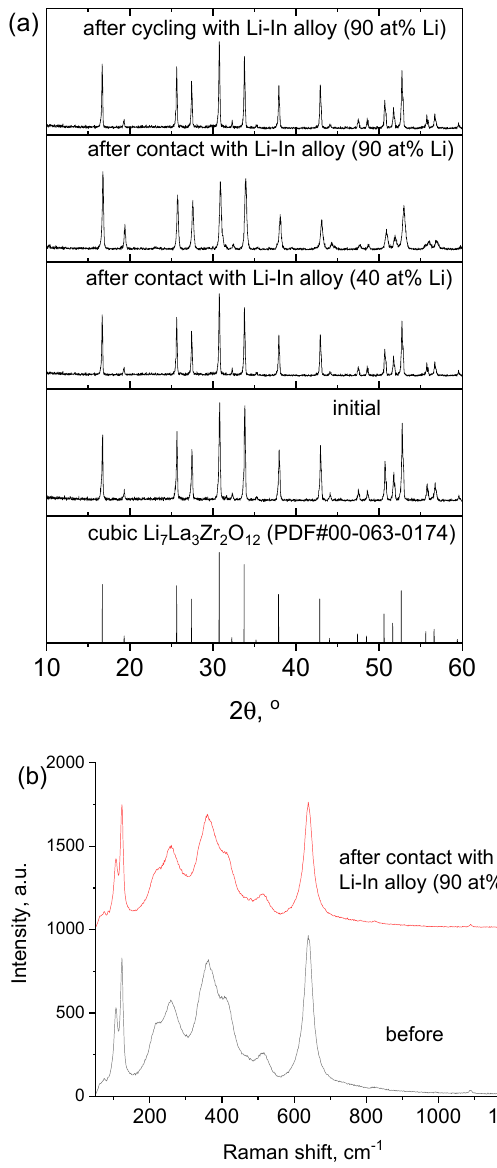
Figure 9. XRD patterns ( a ) and Raman spectra ( b ) of LLZc + 1 wt% LYS solid electrolyte surface after contact with lithium–indium anode.